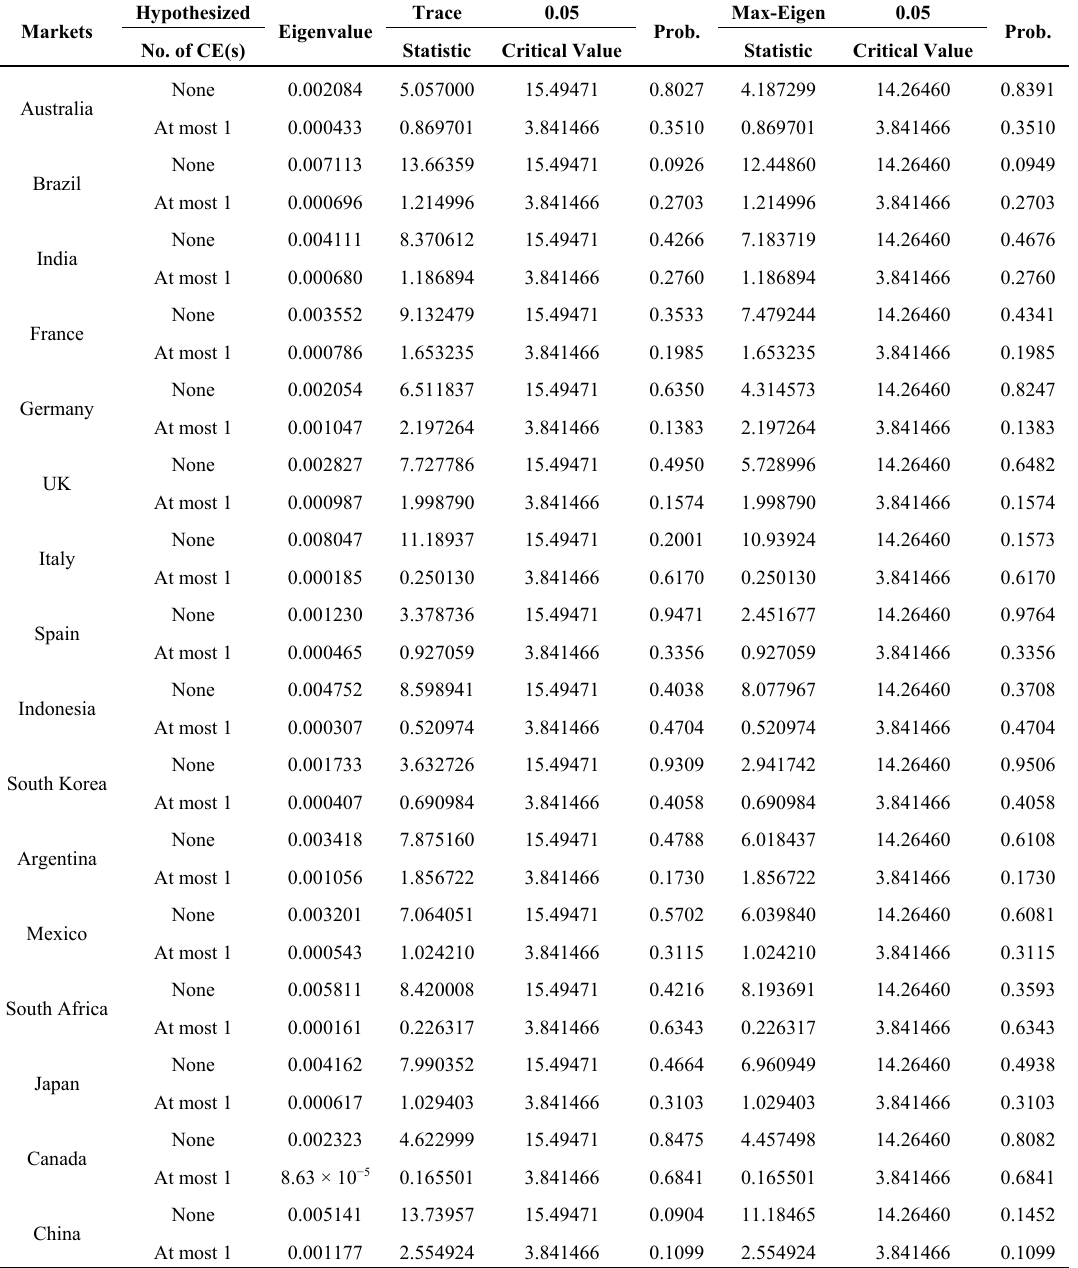
Table A6. Test for Johansen Cointegrtion in Main Period